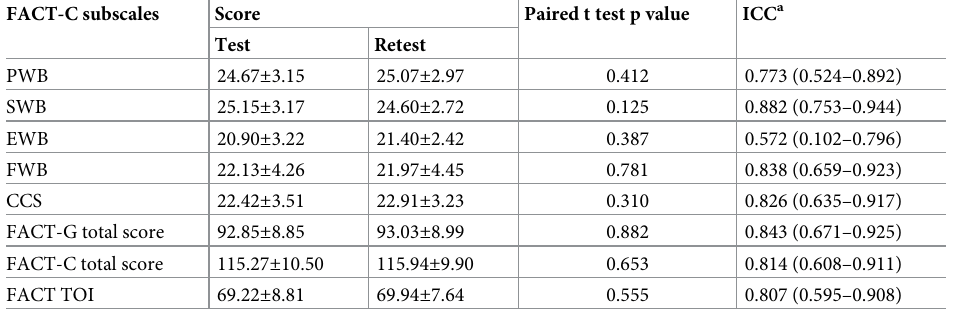
Table 5. Reliability of FACT-C